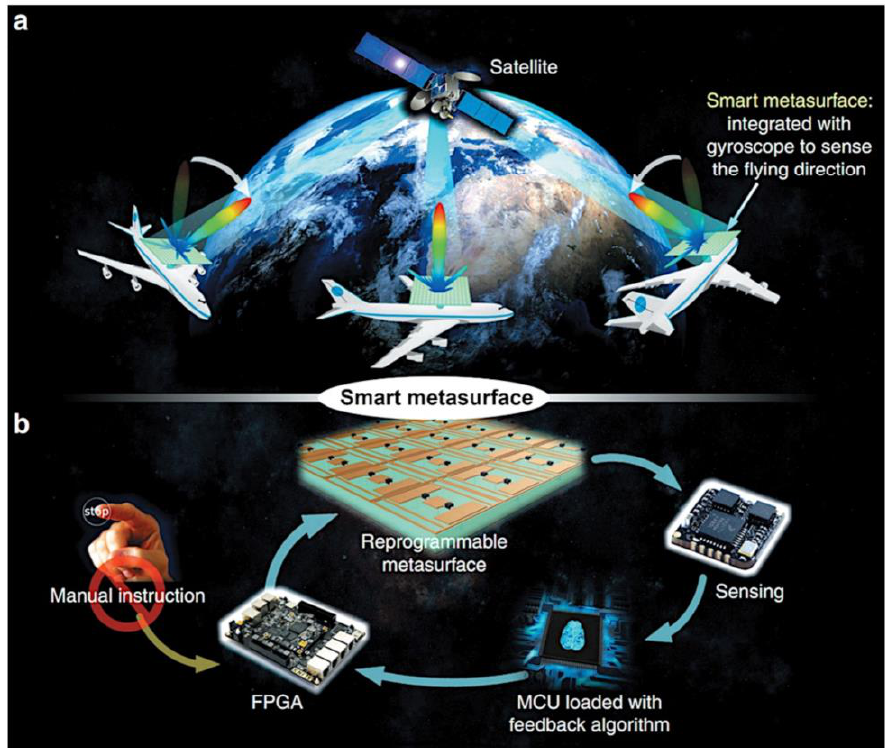
Figure 7. ( a , b ) Smart metamaterials may be used for various aerospace technology and many other applications. Reprinted from Ref. [107] under terms and conditions of CC BY License. Copyright 2019, the Authors.